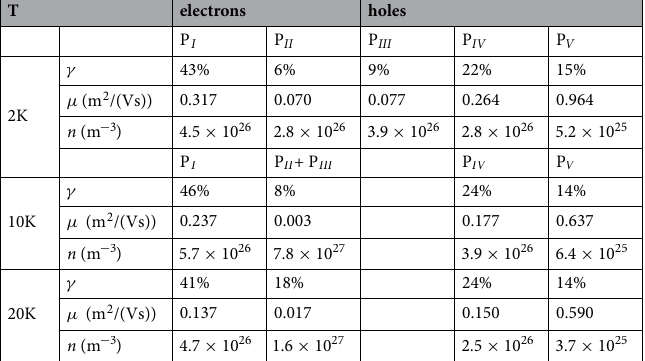
Table 1. Information of each peaks separated by MEMSA: contribution to the conductivity γ , average mobility µ , and change concentration